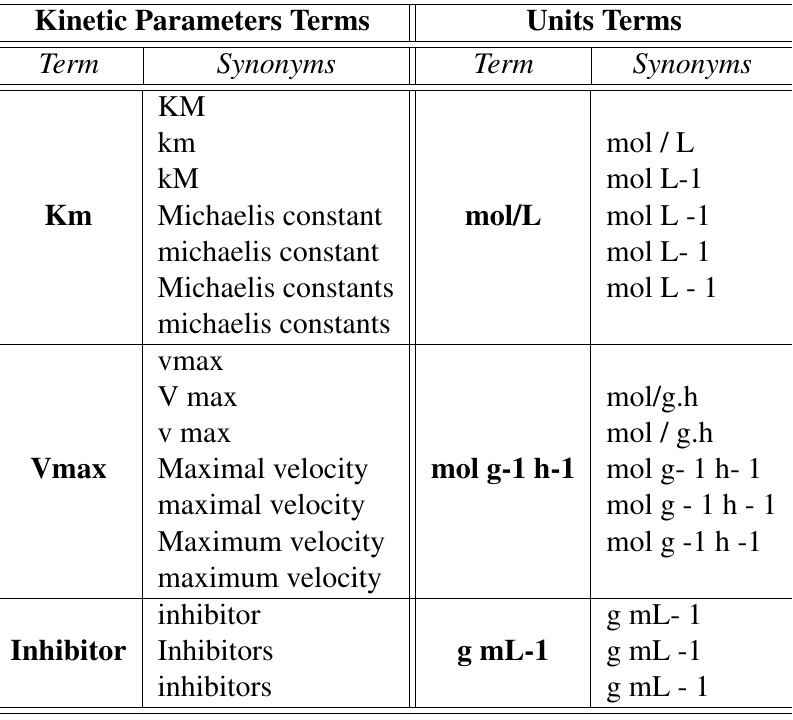
Table 1: Examples of terms listed in the dictionaries “kinetic parameters” and